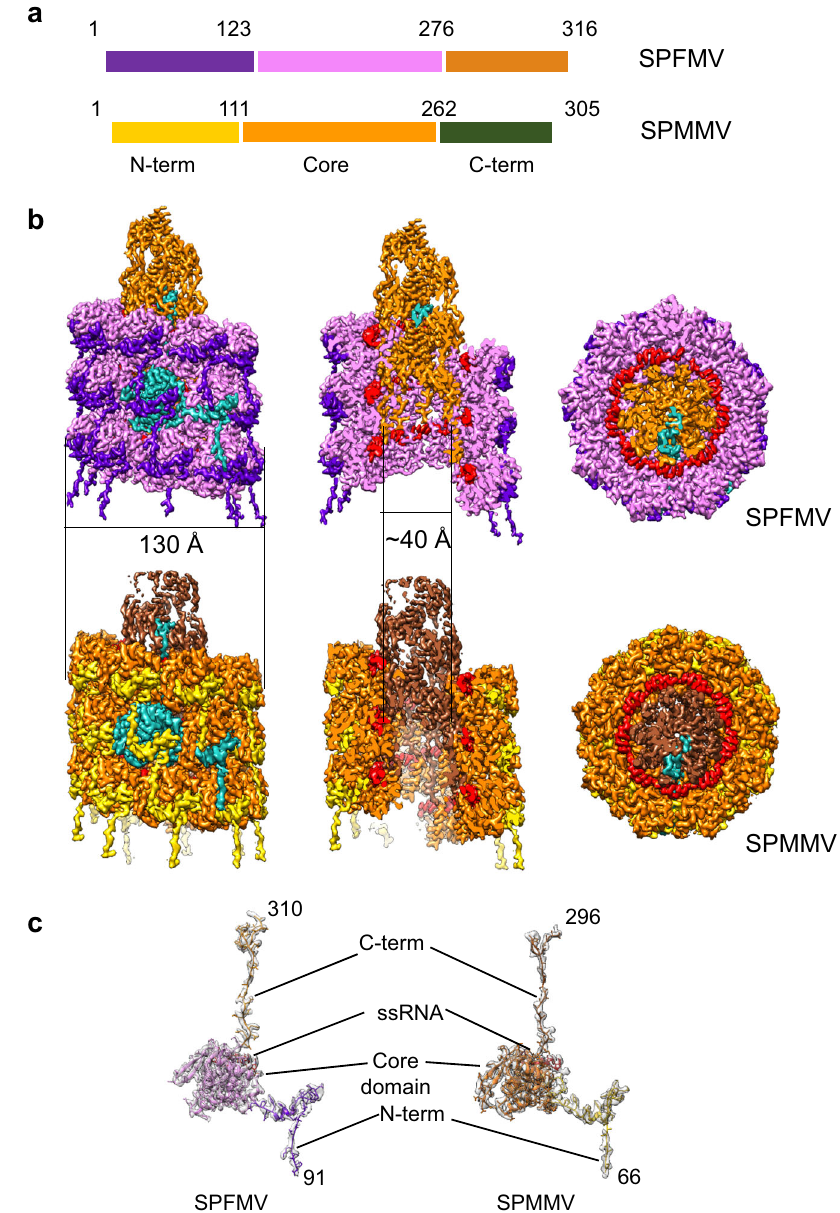
Fig. 4 CryoEM structures of Potyviridae -VLPs. a Schematic organization of SPFMV and SPMMV VLPs, colour coded according to the three domains and number of residues indicated for the corresponding coat protein sequences. b CryoEM maps for the indicated VLPs of SPFMV and SPMMV. The maps are coloured according to the three domains in the single coat protein used in ( a ) with one of the coat proteins in both structures coloured in cyan. Both panels show the cryoEM maps in side-view (left), cut-away view (middle) and top view (right). The ssRNA is coloured in red, and the outer and inner diameters are labelled. c CryoEM map fi tted structural models for individual coat proteins from SPFMV (left) and SPMMV (right) are shown, labelled with coat protein